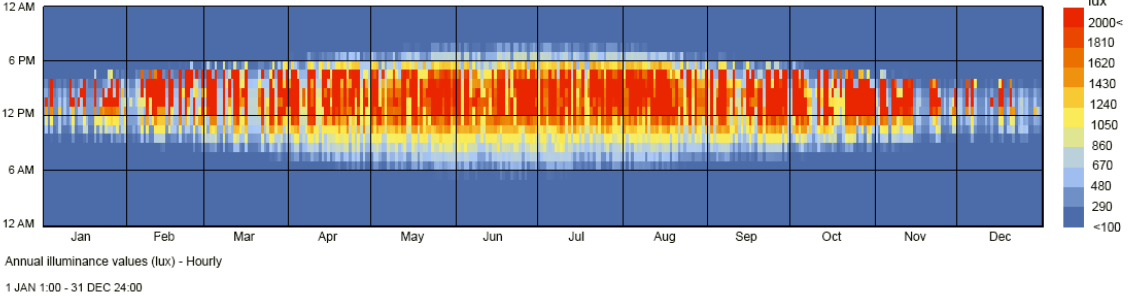
Fig. 10 GLZ (0.59/0.43): Annual hourly illuminance map of the reference